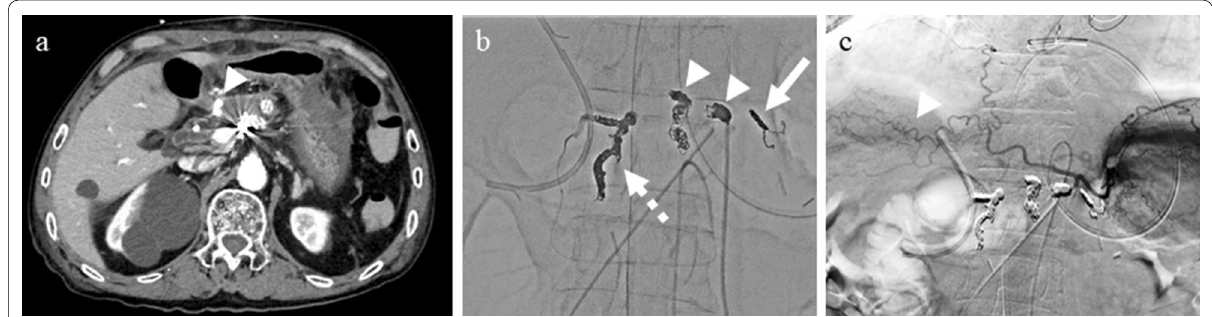
Fig. 6 Imaging findings at postoperative day 32. a Enhanced CT showed pseudoaneurysm at the gastroduodenal artery (arrowhead). b Angiography showed the partially dislocated coil placed at the common hepatic artery (arrowhead), left gastric artery (arrow), and gastroduodenal artery (dotted arrow). c Angiography from the root of the celiac artery showed intrahepatic arterial flow (arrowhead) from the right inferior phrenic artery